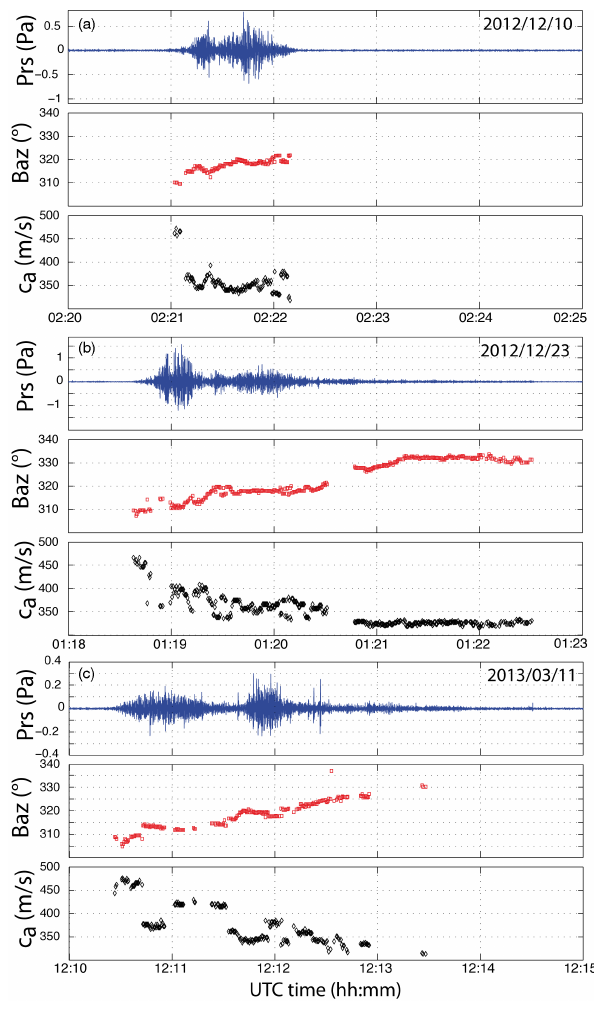
Figure 8. Infrasonic record at the central element of the array (blue), back azimuth (red) and apparent velocity (black) of infrasound de- tections for the three events extracted automatically from the whole data